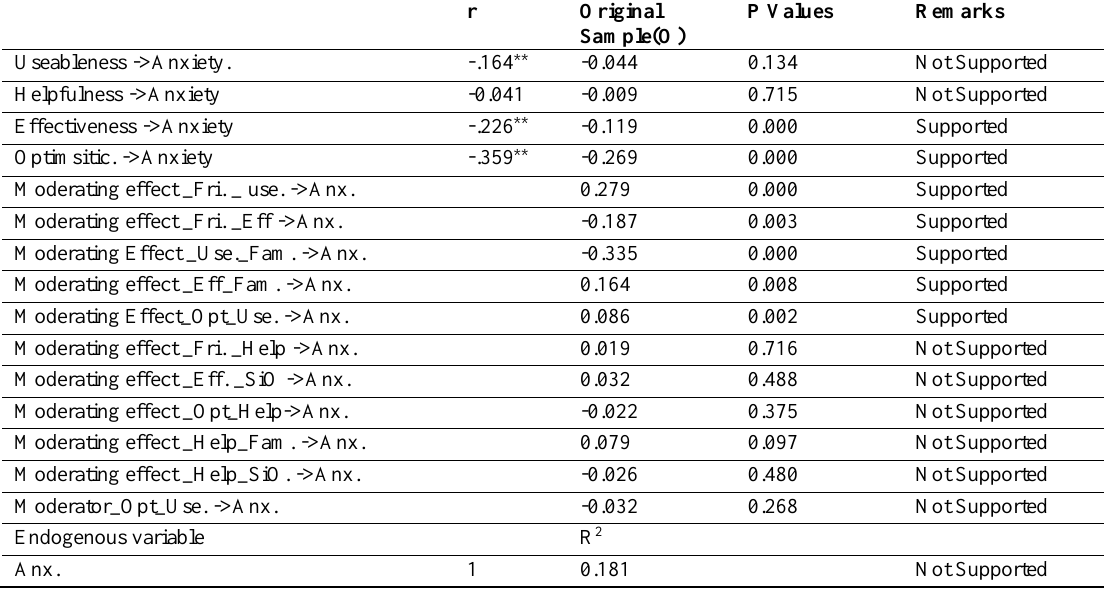
Table 4: Path analysis for causality relationships between variables